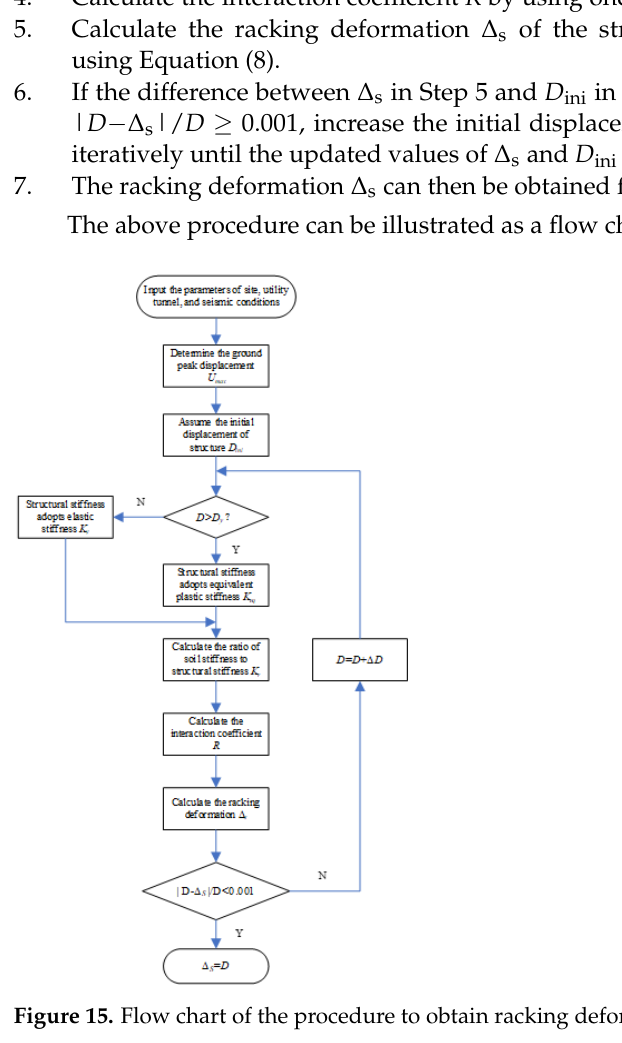
Figure 15. Flow chart of the procedure to obtain racking deformation.